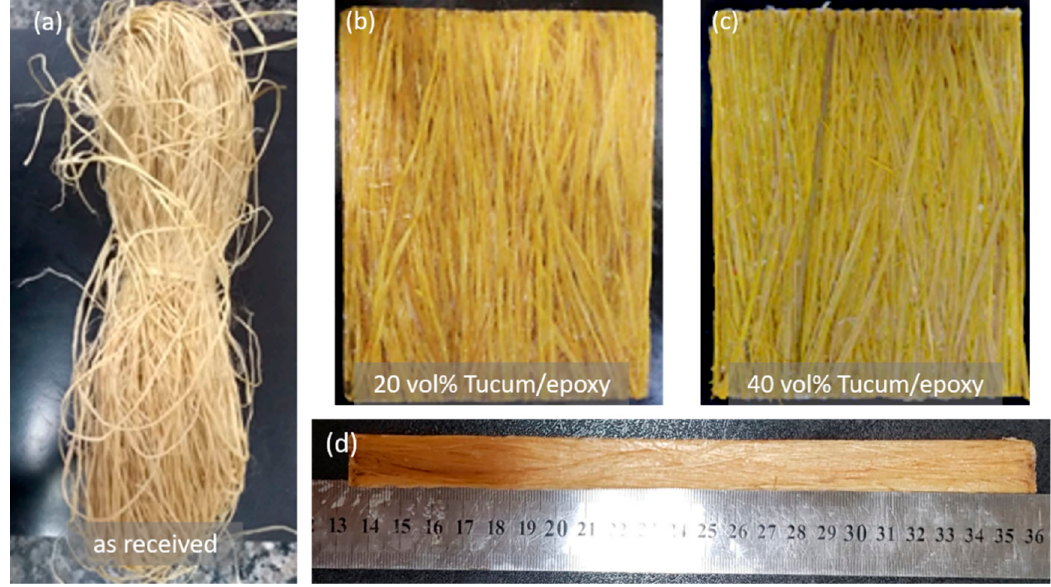
Figure 2. ( a ) Tucum fiber as-received, and epoxy composite plates with continuous and aligned tucum fiber in different volume fractions: ( b ) 20%; ( c ) 40%; ( d ) upper